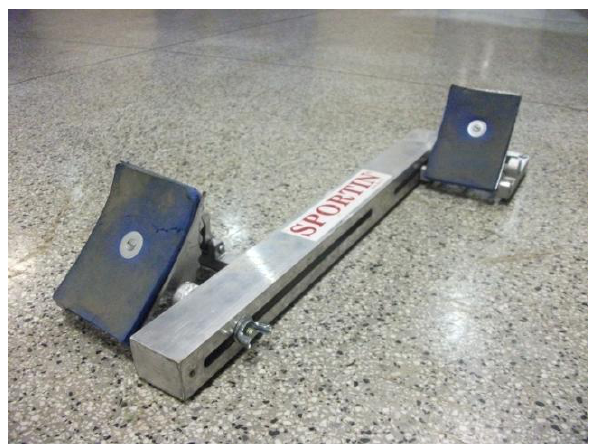
Figura 9- Bloco de partida de metal (Fonte: Própria) Atualmente, os blocos de partida utilizados em competições oficiais assemelham-se aos da figura 8, sendo comum um sistema de regulagem para atender às necessidades de cada